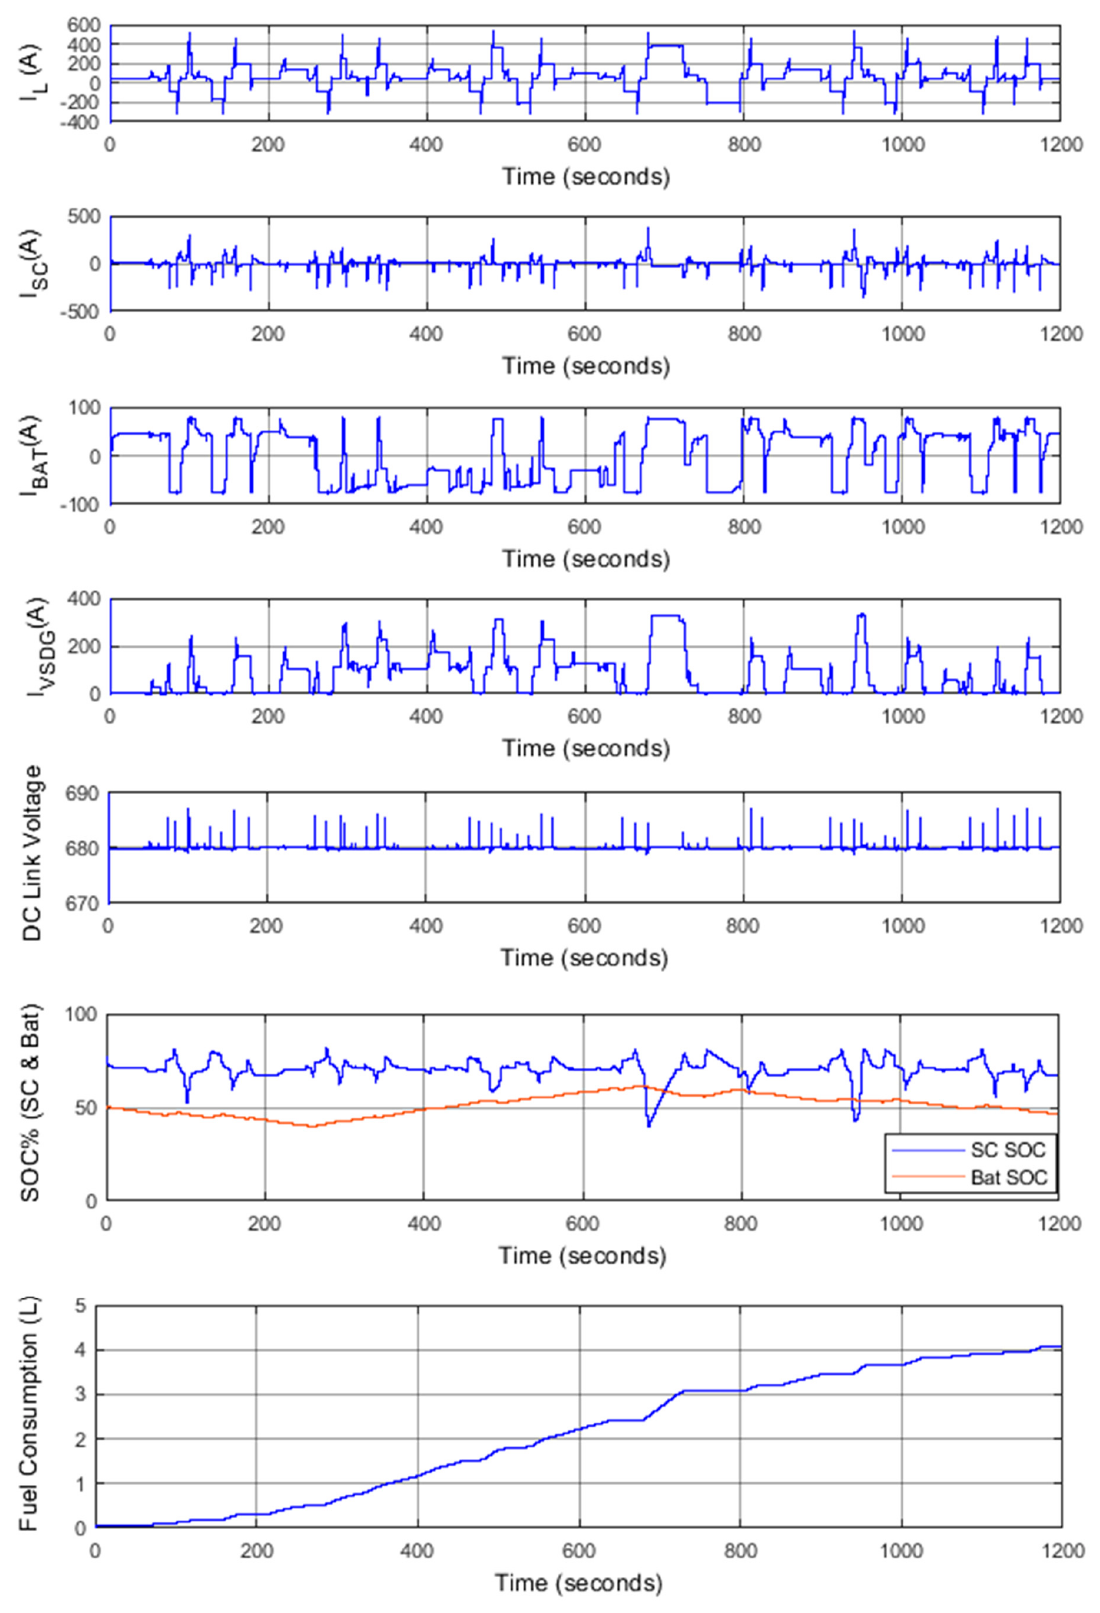
Figure 15. SOC and current variations of Case 4